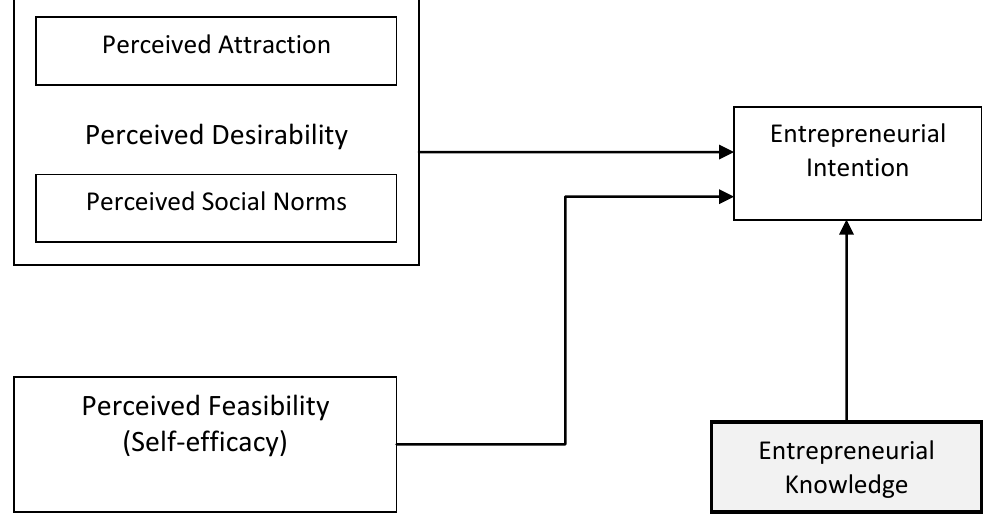
Figure 1: The Entrepreneurial Intention Model (Linan, 2004; also cited in Pribadi,